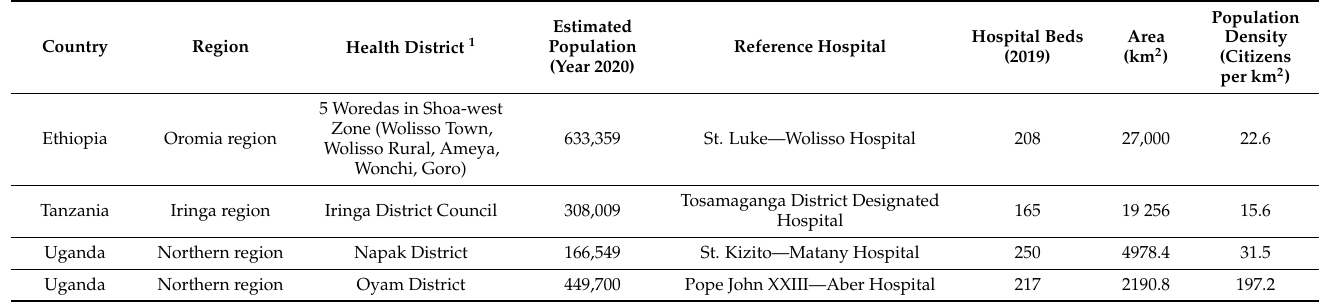
Table 4. List of the analysed hospitals and their relative health districts or catchment